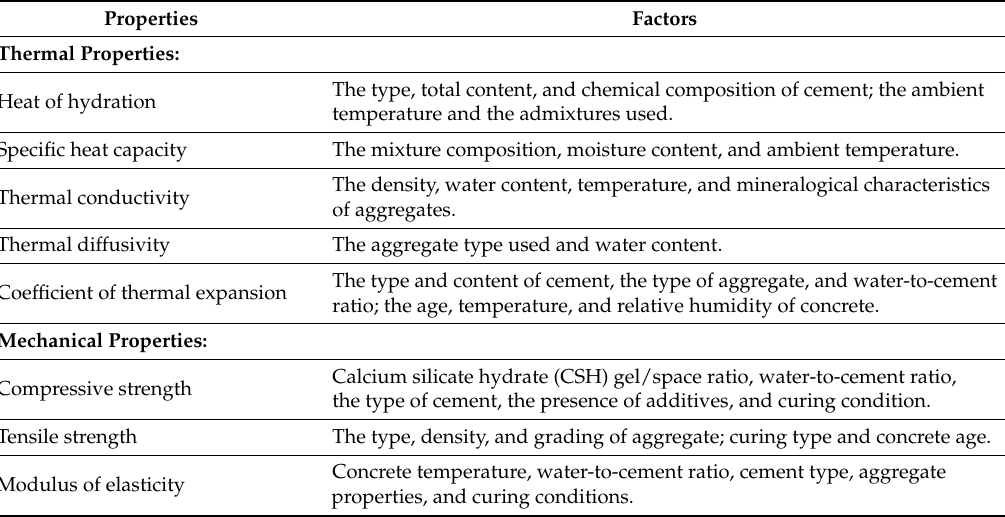
Table 1. Factors which influence the thermal and mechanical properties of hardening